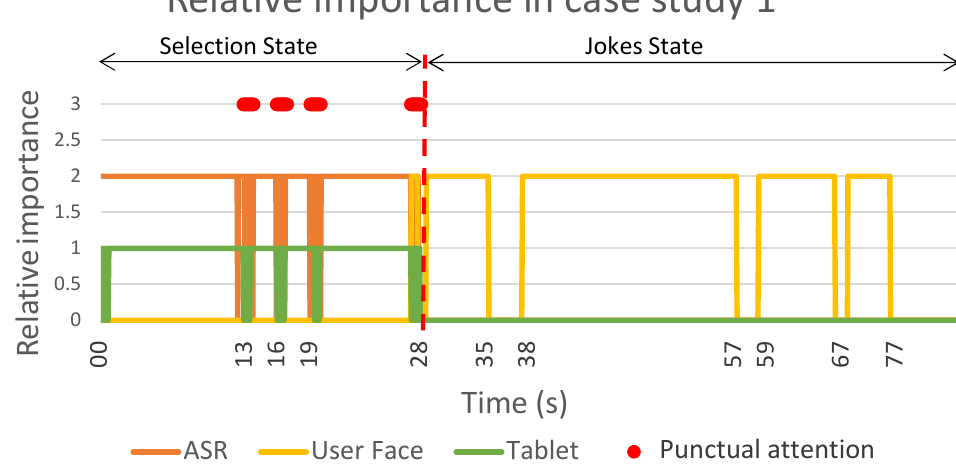
Figure 7. The relative importance of the detectors during sustained and punctual attention in case study 1. The orange, yellow and green lines show the sustained attention of the ASR, the user’s face and the tablet, respectively. The red dots display the punctual attention that was detected during the case